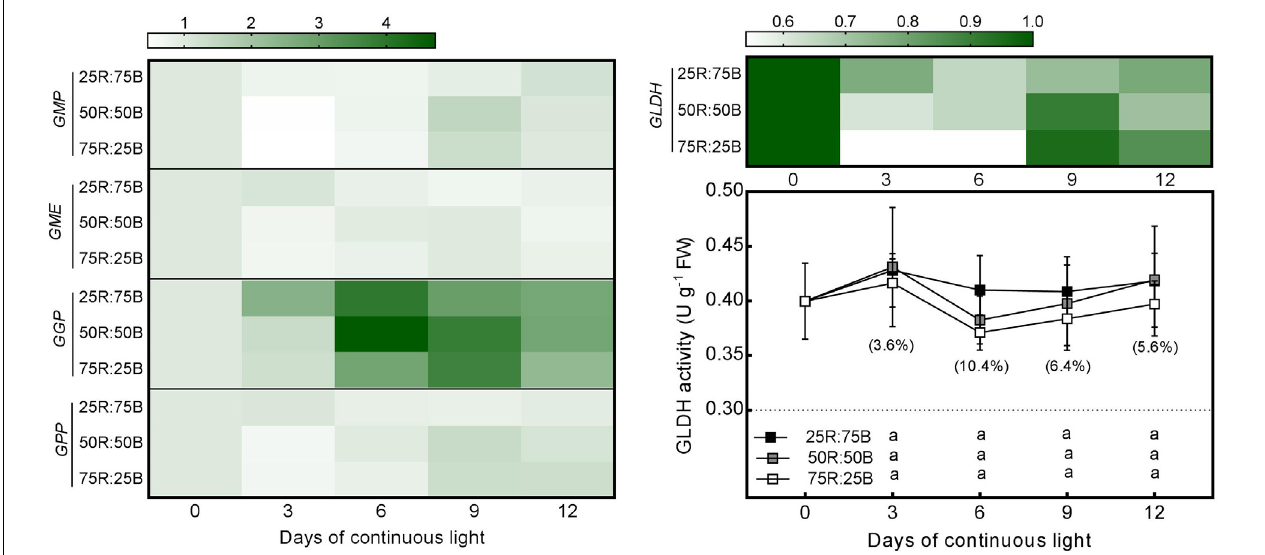
FIGURE 3 | Effects of the red:blue light ratio on the transcript level of enzymes involved in the AsA biosynthesis pathway and activity of L-galactono-1,4-lactone dehydrogenase (GalLDH) in lettuce leaves under continuous light (200 200 µ mol · m – 2 · s – 1 ). Transcript level data are the mean values of three replications. Enzyme activity data are the mean values ± SD of four replications. Different letters indicate significant differences between different red:blue light ratio treatments at p < 0.05 according to Tukey test. Data in brackets were the increasing rate of the maximum value to the minimum value on the same